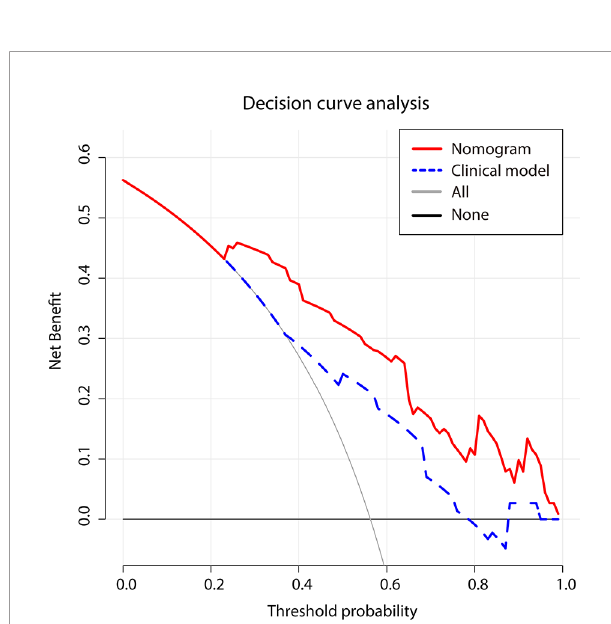
FIGURE 7 | Decision curve analysis for two models. The use of the nomogram for early recurrence prediction provides more bene fi t than two extreme conditions [the treat-all-patients scheme (gray line) and the treat- none scheme (horizontal black line)]. Nomogram (red line) receives a higher net bene fi t than the model based on clinical factors (blue line) across a full range of reasonable threshold